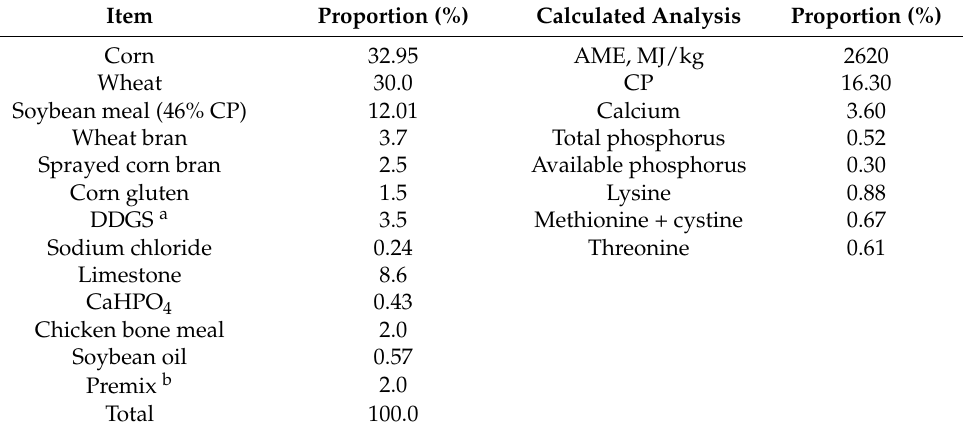
Table 1. Ingredients and calculated analysis of nutrient in the basal diet